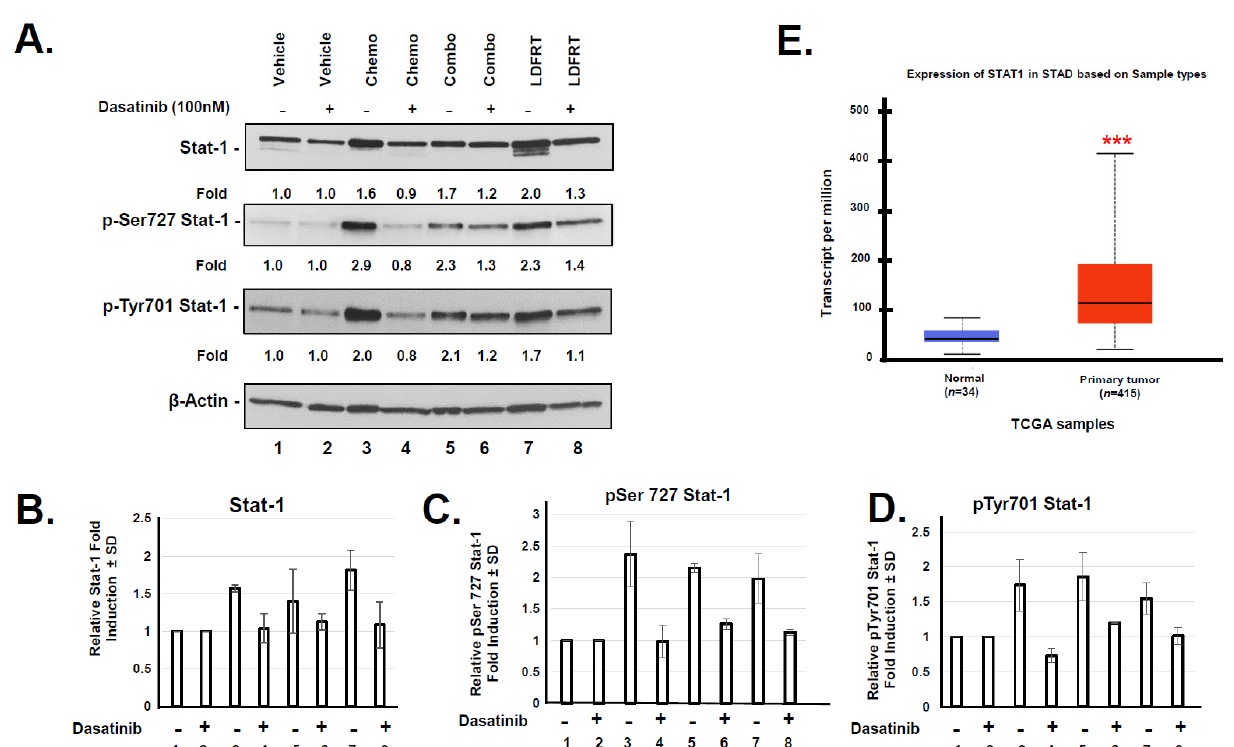
Figure 8. Stat-1 response to mDCF and LDFRT in NCI-N87 cells. ( A ) Western blot analysis of total Stat-1, and Stat-1 phosphorylated at Serine 727 (p-Ser727) and Tyrosine 701 (p-Tyr701). Cells were exposed to the indicated treatment and pre-treated (+) or not ( − ) with the Src kinase inhibitor Dasatinib. ( B – D ) Fold induction measured by densitometry and normalized to Actin and the untreated sample (Vehicle). ( E ) Expression of Stat1 in normal and stomach adenocarcinoma (STAD) from TCGA samples accessed on 28 July 2021. [24]. Student’s t -test, *** p < 0.0005.